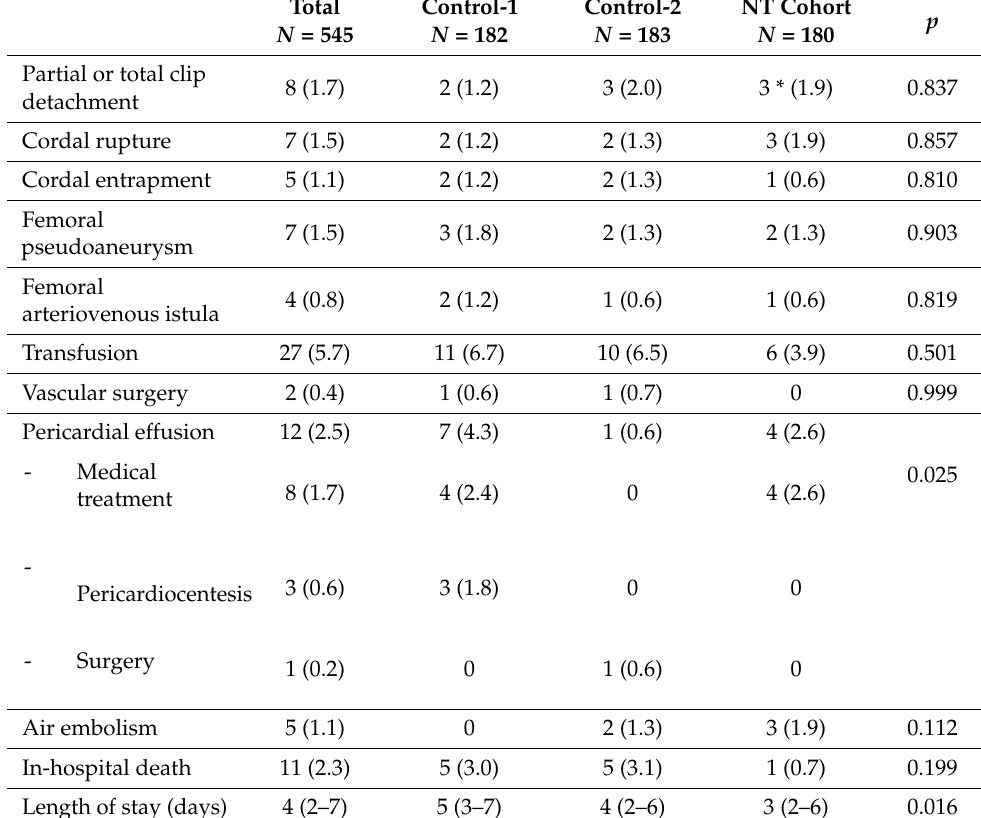
Table 3. In-hospital outcomes.